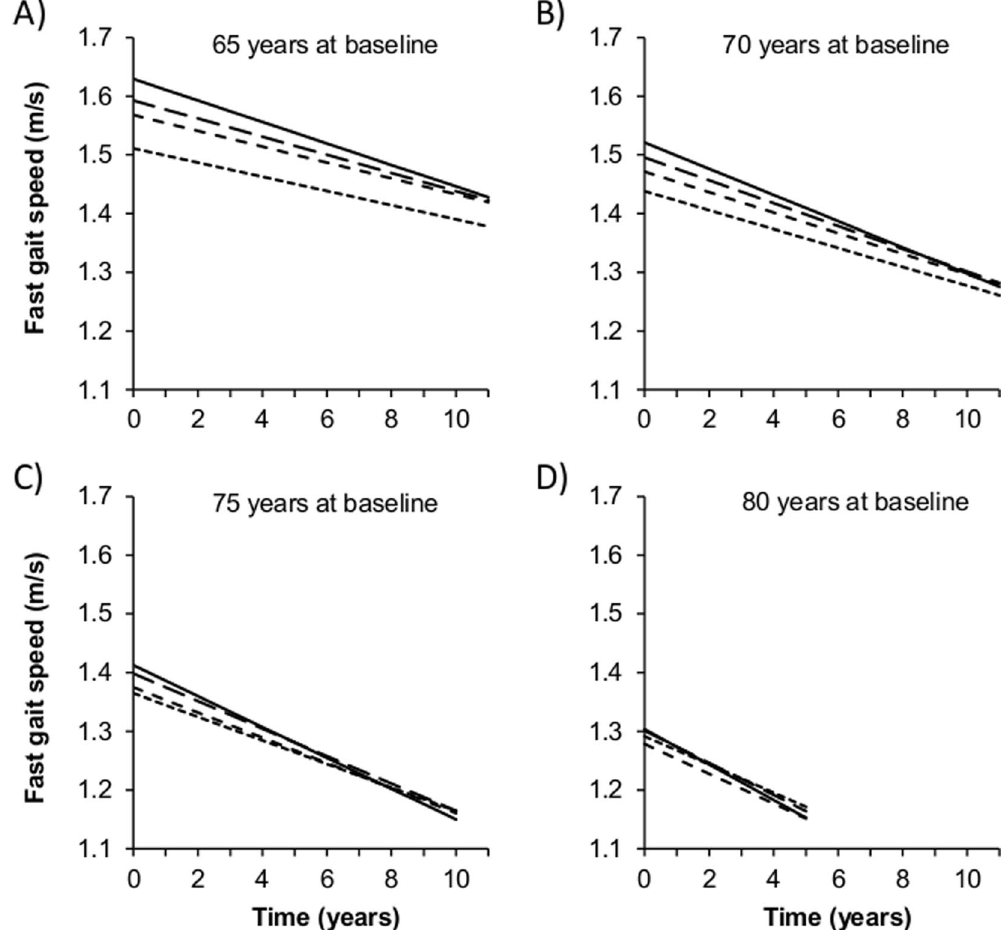
Figure 1. Predicted Trajectories of Fast Gait Speed According to Quartiles of Height in Women Aged 65 ( A ), 70 ( B ), 75 ( C ), and 80 ( D ) Years at Study Baseline. Fast gait speed was modelled using a linear mixed model including a random intercept and slope (results are shown in Table 3 and the corresponding equations as supplementary methods). Quartiles of height: short dashed line, Q1 (shorter); intermediate dashed line, Q2; long dashed line, Q3; solid line, Q4